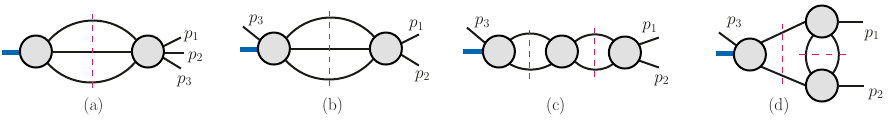
Figure 3 . Complete set of cuts fully probing contributions from all the master integrals.